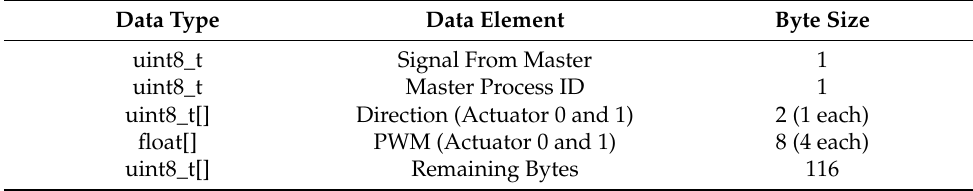
Table 2. CONTROL signal data